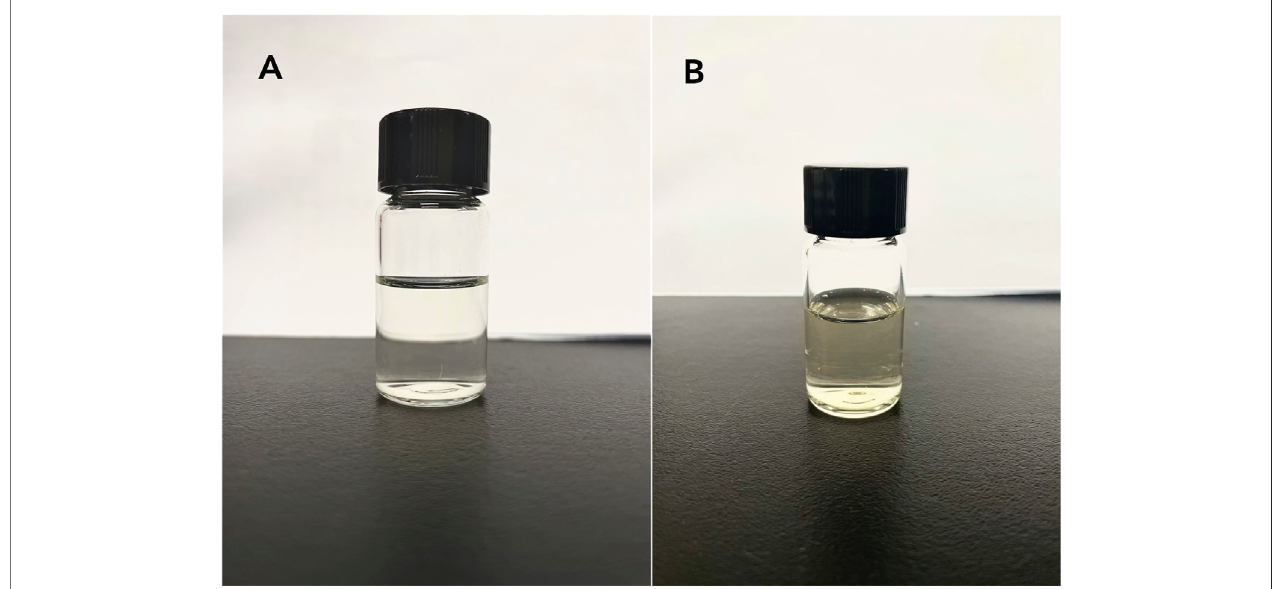
FIGURE 8 | Long-term stability of LFs microemulsion (A) : freshly prepared (B) : stored for 6 months.